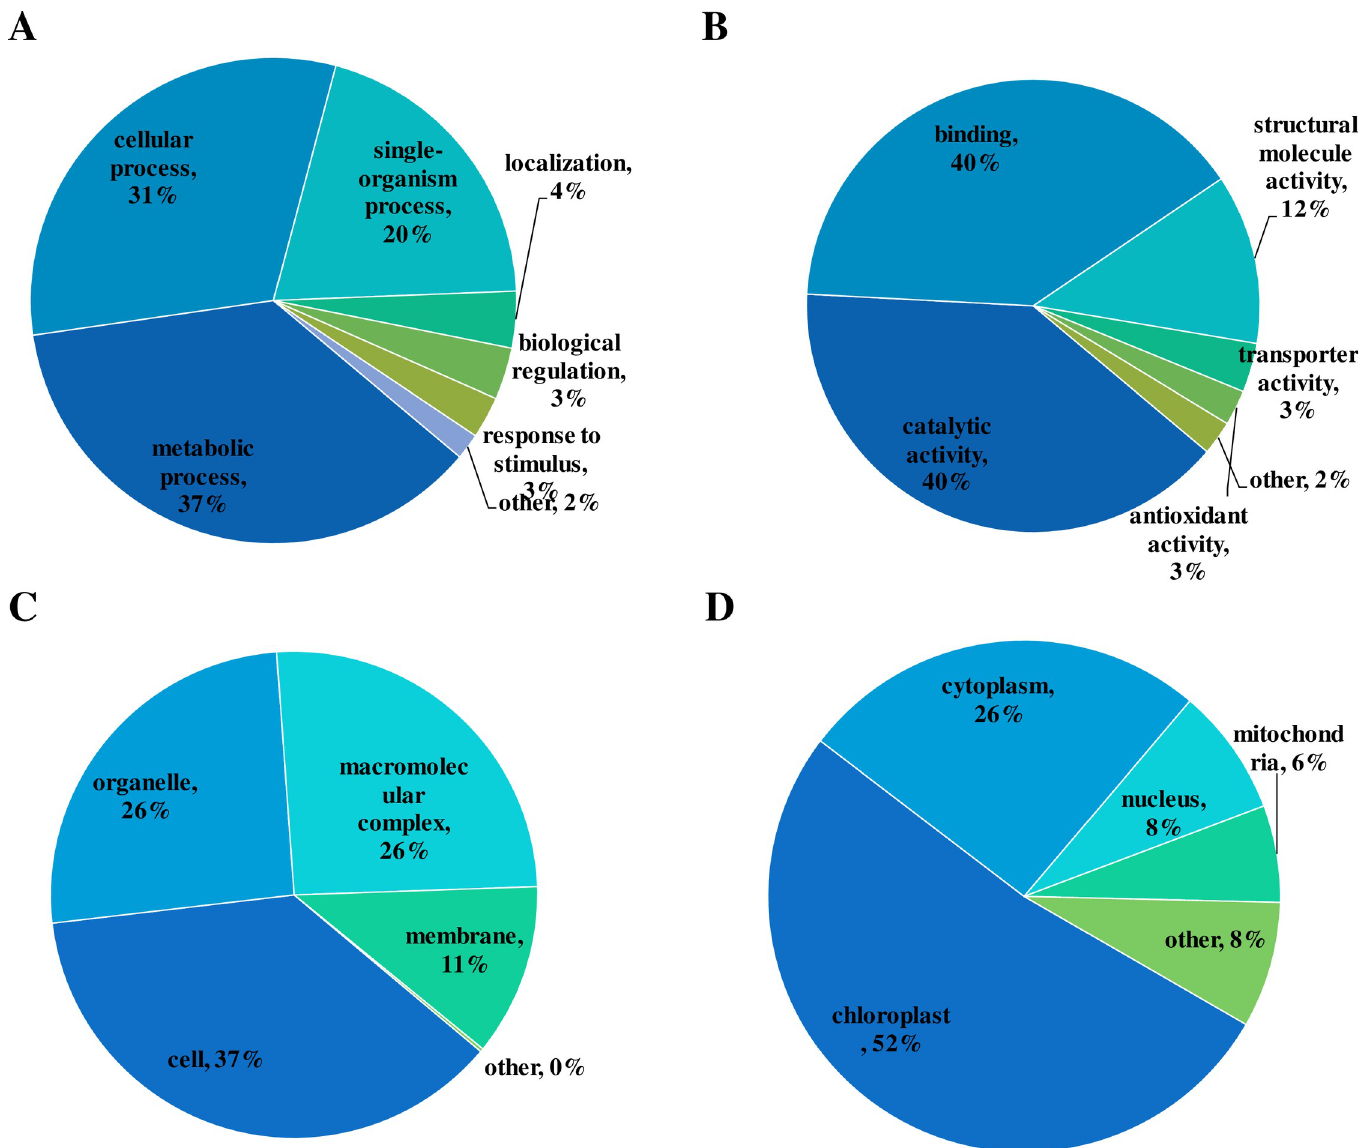
Fig 4. Function classification and subcellular localization of the detected Khib proteins. (A) Cellular component classification. (B) Biological process classification. (C) Molecular function classification. (D) Subcellular localization analysis.